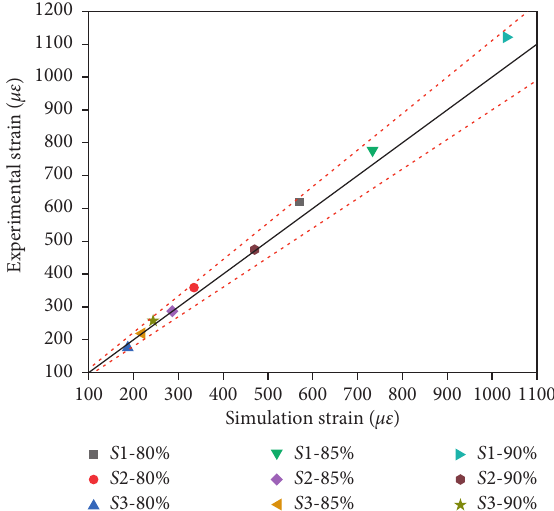
Figure 9: Comparison graph of numerical simulation and test results.